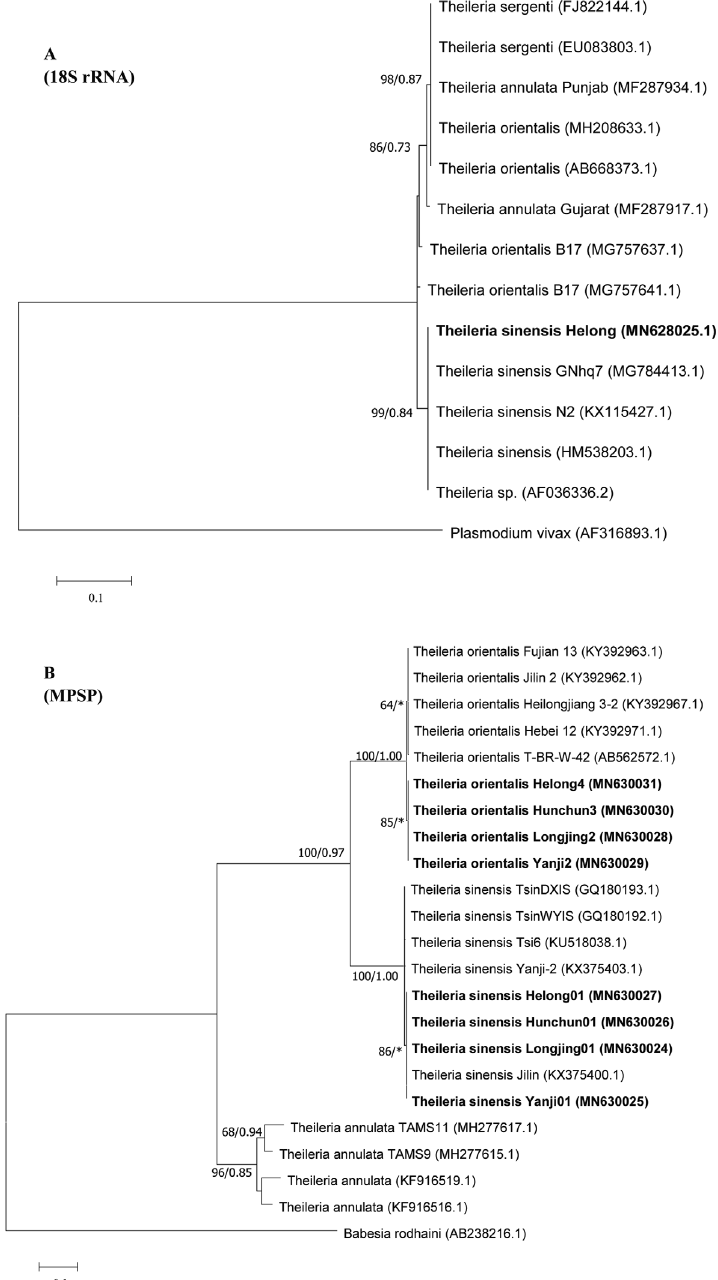
Figure 2. Phylogenetic trees based on the (A) 18SrRNA and (B) MPSP sequences of bovine Theileria. The ML tree was derived from a Tamura 3-parameter model using MEGA7, and Bayesian Inference by Mrbayes3.2 with the GTR + G + I model. ML bootstrap and BI posterior probabilities values are shown at the nodes in the order ML/BI. Bootstrap values <50 are not reported. Posterior probabilities <0.7 are not reported. The newly generated sequences in the present study are shown in